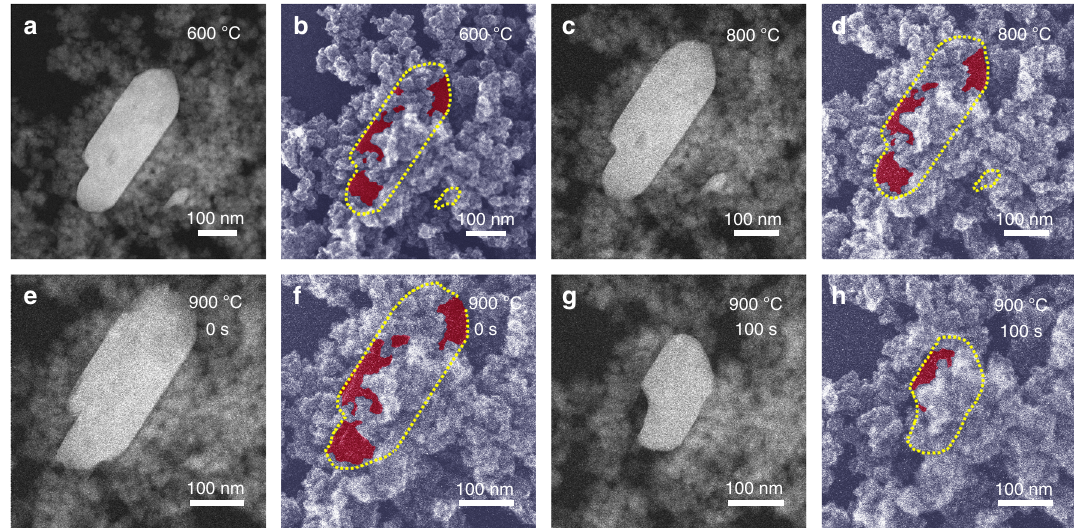
Fig. 4 In situ characterization of RuO 2 dispersion. a , c , e , g In situ AC-HAADF-STEM images and b , d , f , h corresponding SE images of a RuO 2 + MAFO physical mixture after calcination at 600, 800, and 900 °C (0 s, 100 s) under fl owing O 2 (2 mL min − 1 and 3.5 Pa). Yellow dashed lines in the SE images silhouette the RuO 2 aggregate, and red regions indicate exposed RuO 2